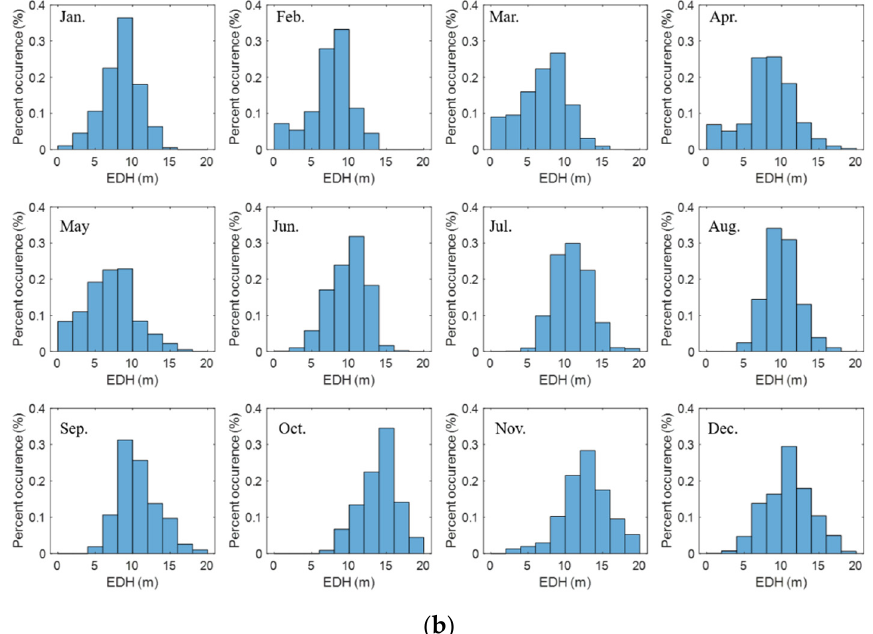
Figure 8. Monthly averages and statistical features of the EDH: ( a ) Monthly average of the EDH. ( b ) Percent occurrence of the EDH.